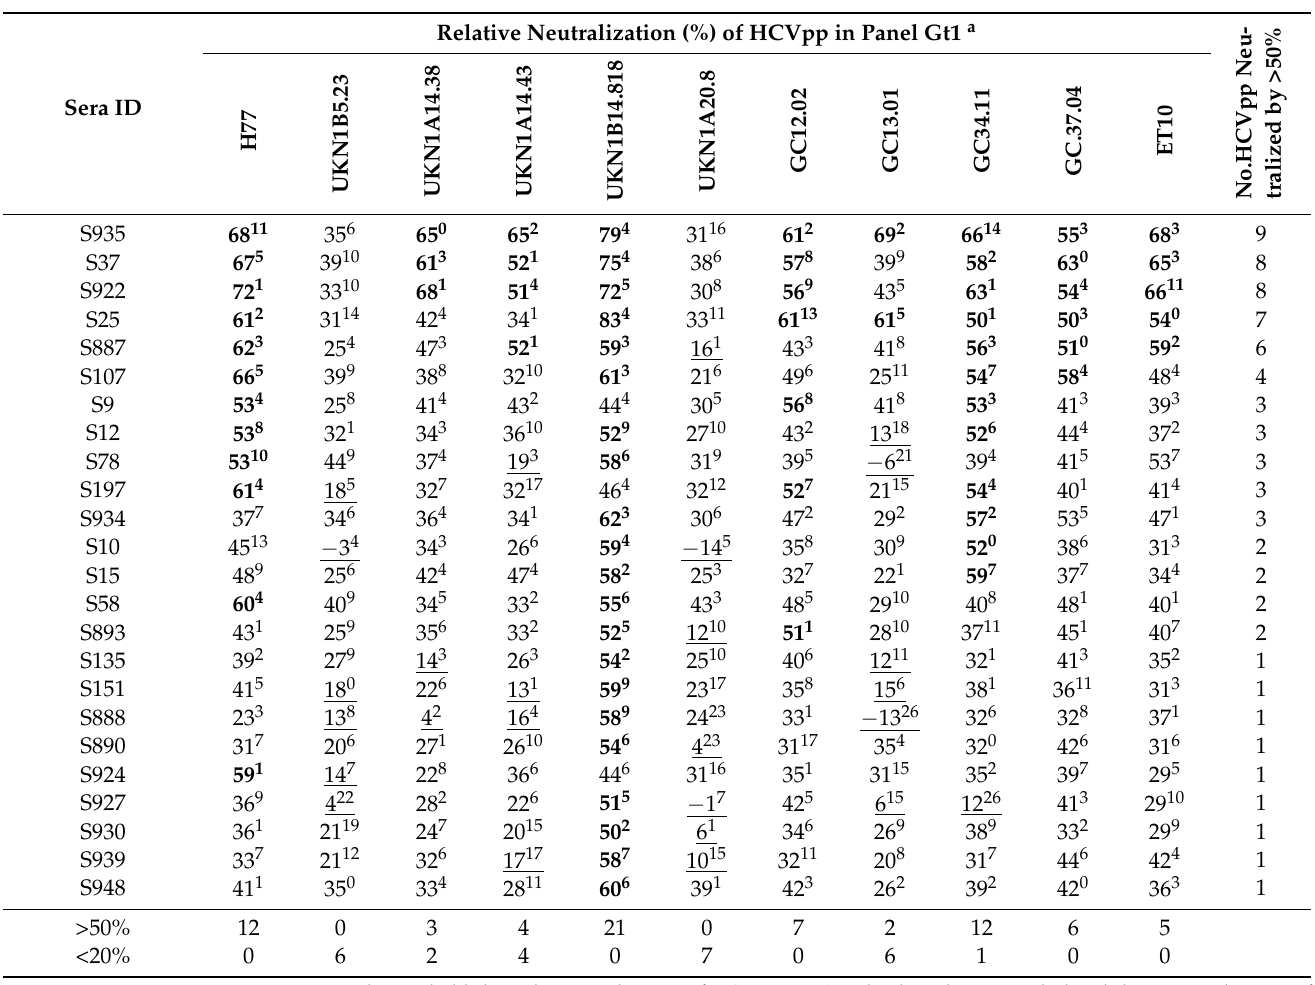
Table 2. Neutralization activity of SR cohort. The relative neutralization activity (%) of the Gt1 panel is shown. The data is the mean value from triplicate independent